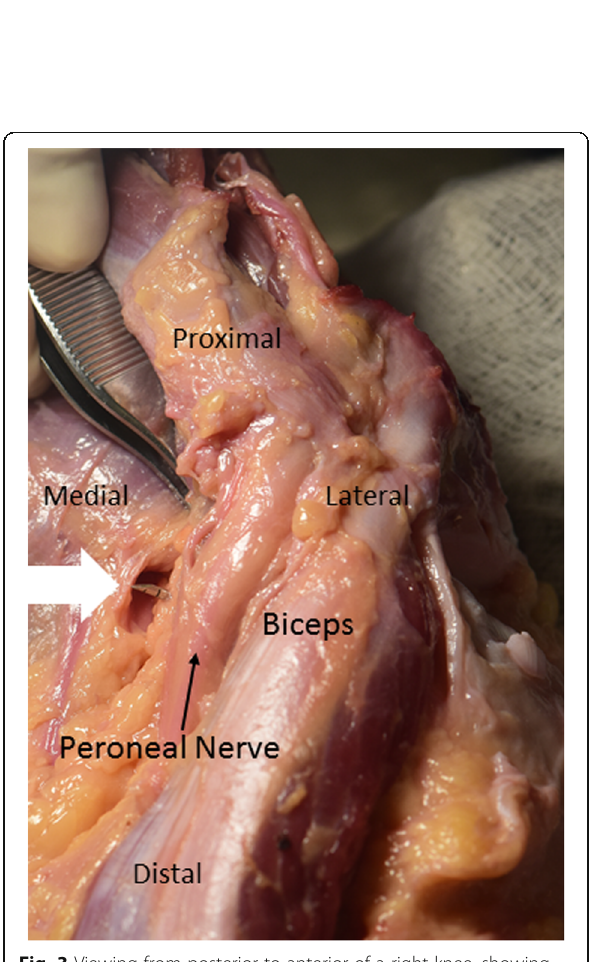
Fig. 3 Viewing from posterior to anterior of a right knee, showing the needle tip (white arrow) adjacent to the peroneal nerve while performing a repair on the medial side of the popliteal